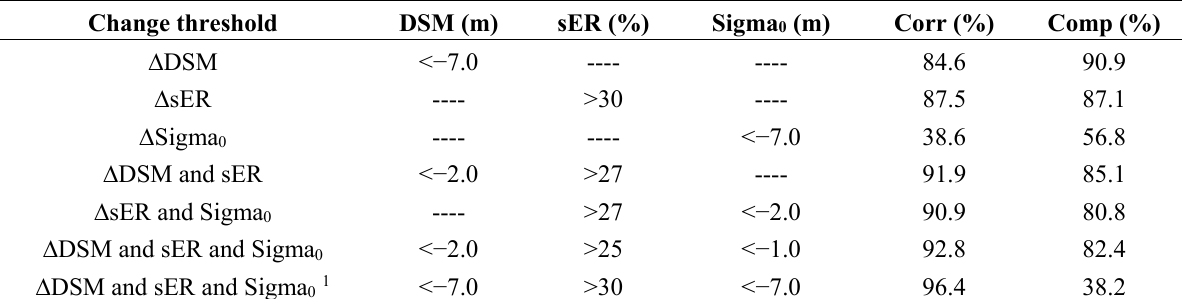
Table 3. Threshold values and accuracy measures.